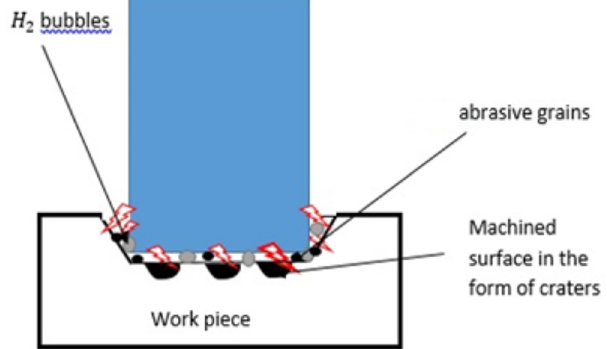
Fig. 2. Mechanism of ECDM with abrasive present in electrolyte.